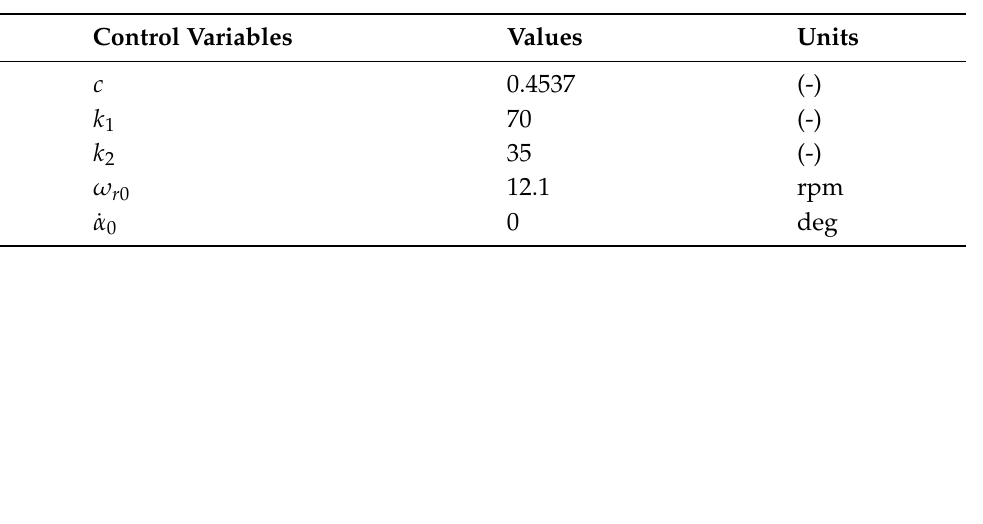
Table 3. Parameters of the proposed model-based twisting